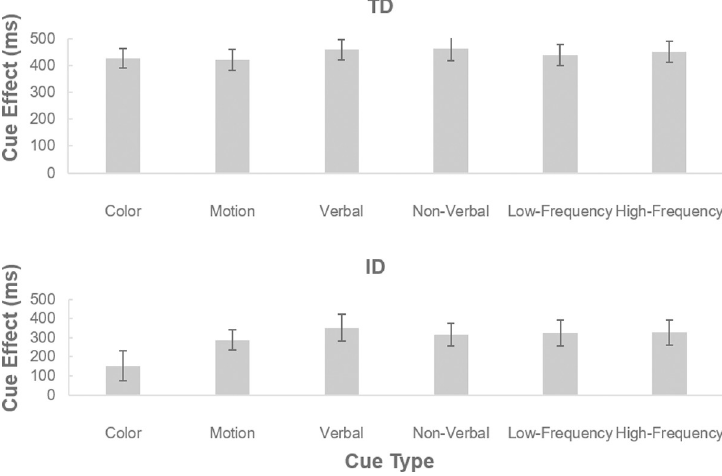
Fig 4. Mean cue effect for each exogenous cue type, shown separately for the TD and ID